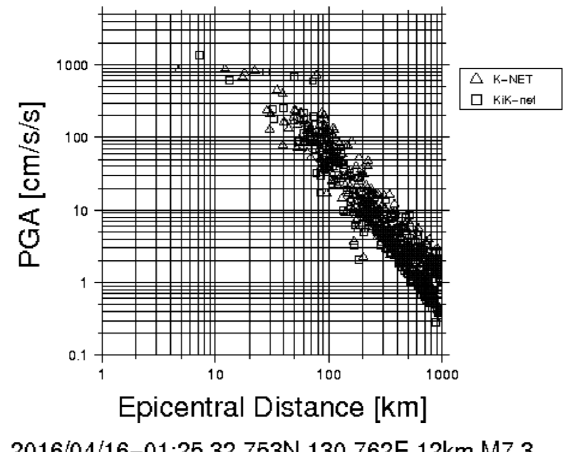
Figure 3. Attenuation trend of the recorded mainshock event on 16 April 2016.